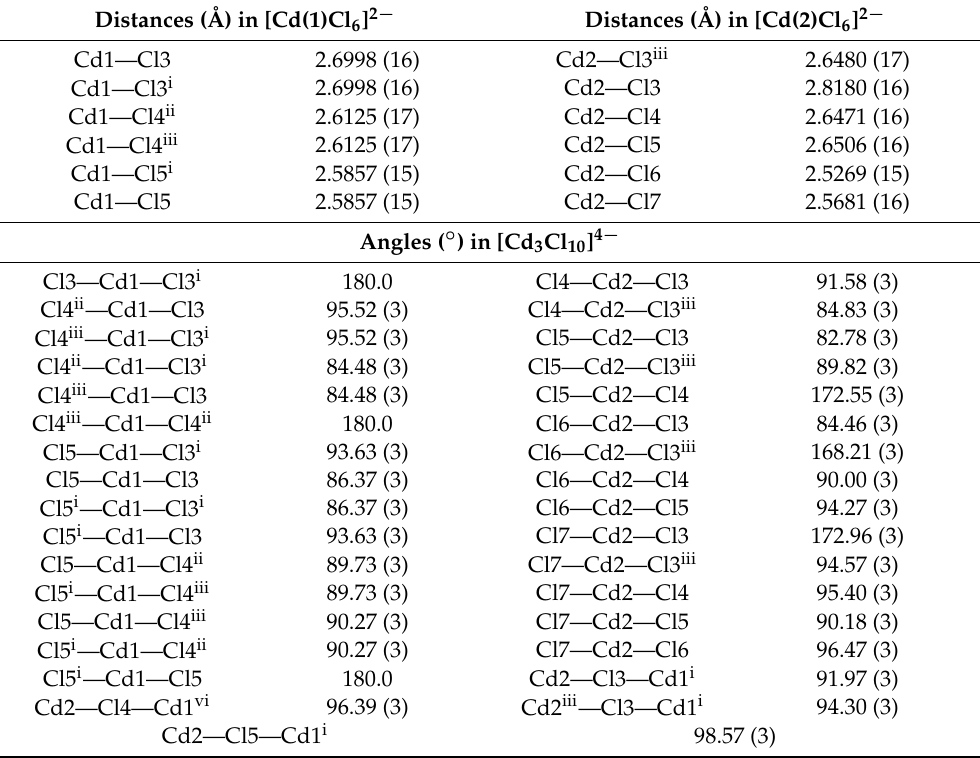
Table 2. Distances and angles of Cd 3 Cl 10 in (C 6 H 8 Cl 2 N 2 ) 2 [Cd 3 Cl 10 ] · 6H 2 O.